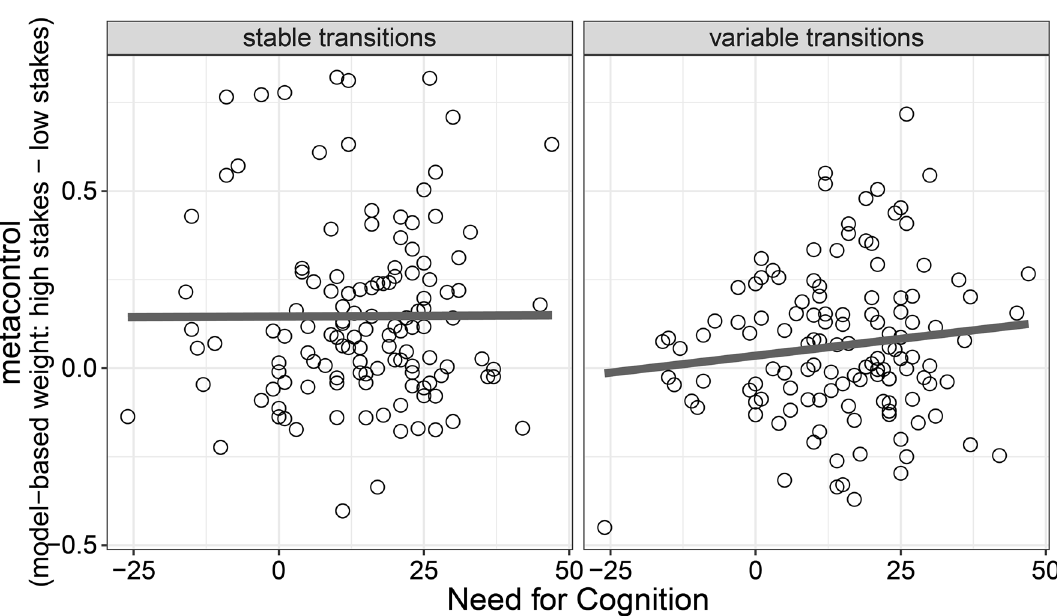
Figure 3. Relationship between NFC (x-axis) and metacontrol of decision making (y-axis) in Study